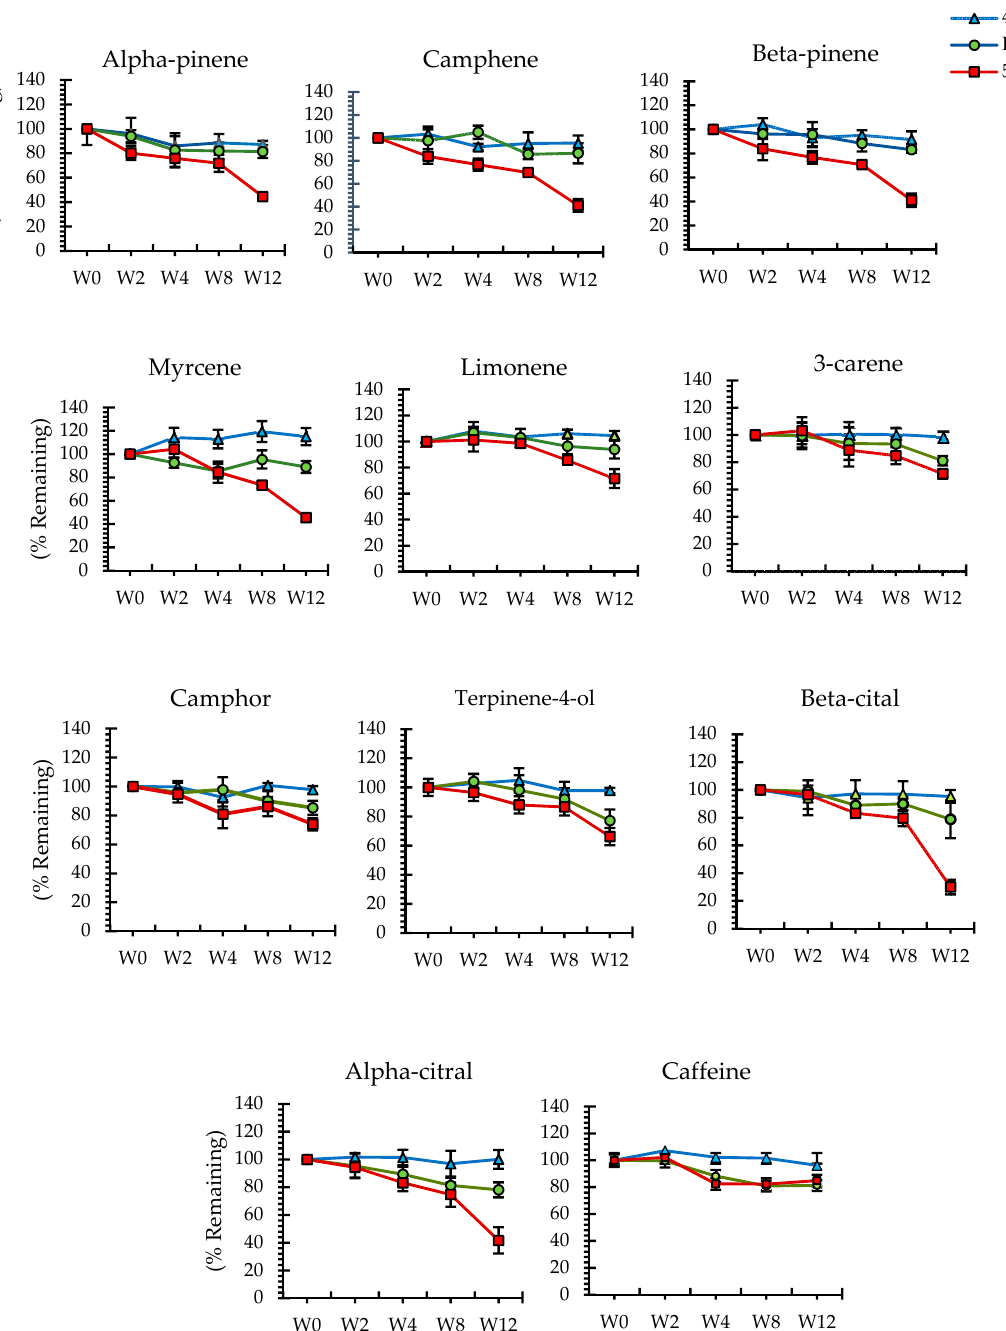
Figure 3. The percentages of the relationship between the time of storage and temperature under room temperature (25 ◦ C), refrigerator (4 ◦ C), and oven (50 ◦ C) conditions. Change in the percentage of constituents of interest, camphor, camphene, citral, 3-carene, limonene, myrcene, α -pinene, β -pinenen, terpinene-4-ol, and caffeine, for 12 weeks.